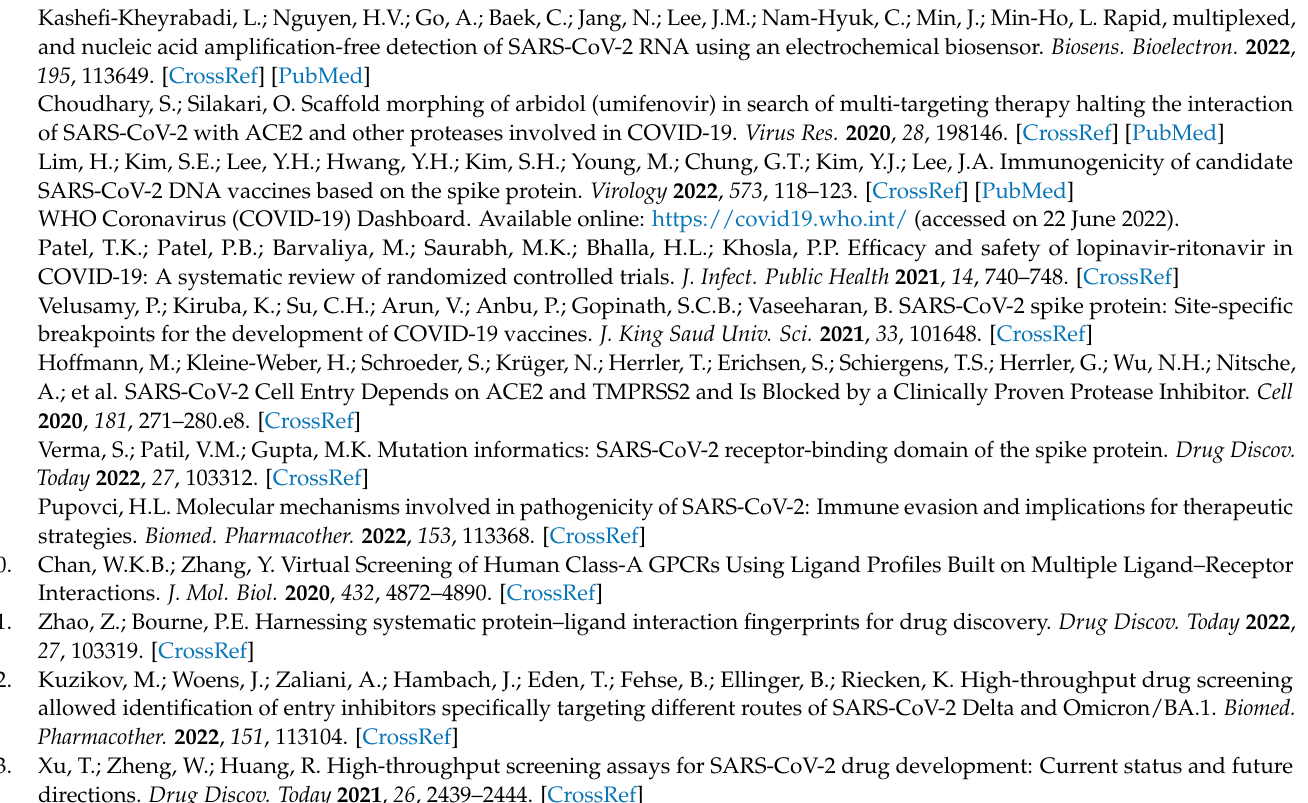
Table S2. The affinity value of the optimal spike protein/hydroxychloroquine binding conformation; Table S3. The affinity value of the optimal spike protein/ribavirin binding conformation; Table S4. The affinity value of the optimal spike protein/bromhexine binding